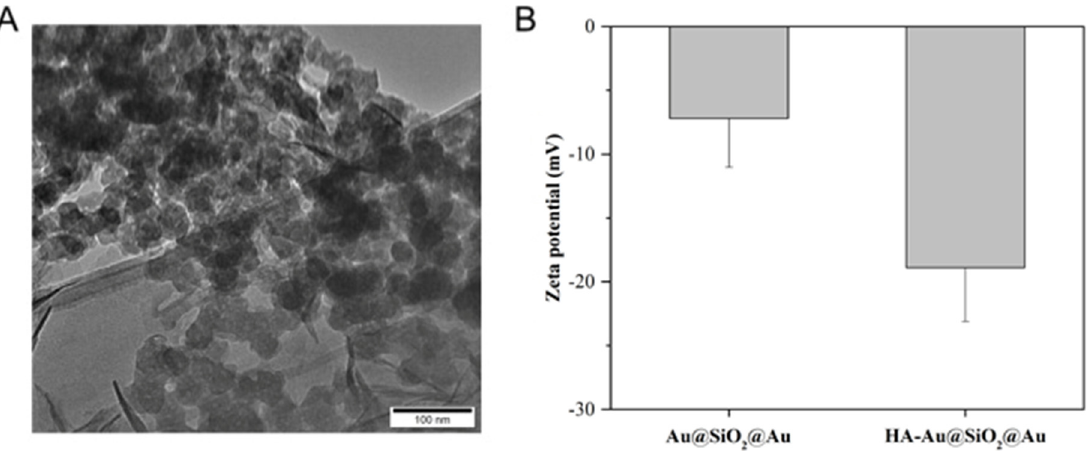
Figure 1. Characterization of nanoparticles. ( A ) TEM images and ( B ) Zeta potential diagram of